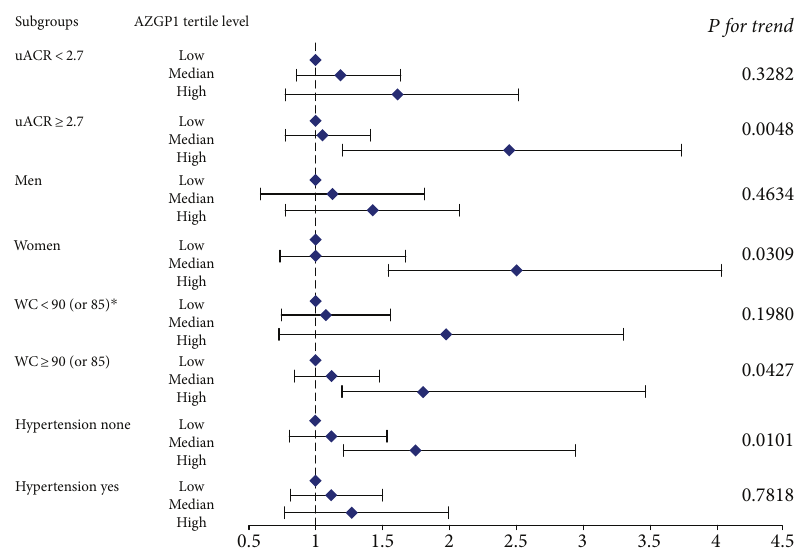
Figure 1: Further logistic regression analysis of eGFR in T2DM patients with the lowest, middle, and highest serum ZAG levels in subgroups analyses. Multivariate odds ratios (OR) and 95% con fi dent interval (CI) from unconditional logistic regression models were used in the analysis, adjusted for age group ( < 61y, ≥ 61 y), gender (men, women), BMI ( < 24, ≥ 24), ∗ WC ( < 90, ≥ 90) in men and ( < 85, ≥ 85) in women, hypertension (none, yes), TC ( < 5.2, ≥ 5.2), TG ( < 1.7, ≥ 1.7), HbA1C ( ≤ 7.0, > 7.0), FBG ( < 7.0, ≥ 7.0), uACR ( < 2.7, ≥ 2.7), and 25OHD VitD ( > 50 or ≤ 50). Strati fi ed variables were also adjusted for in the subgroup analysis when